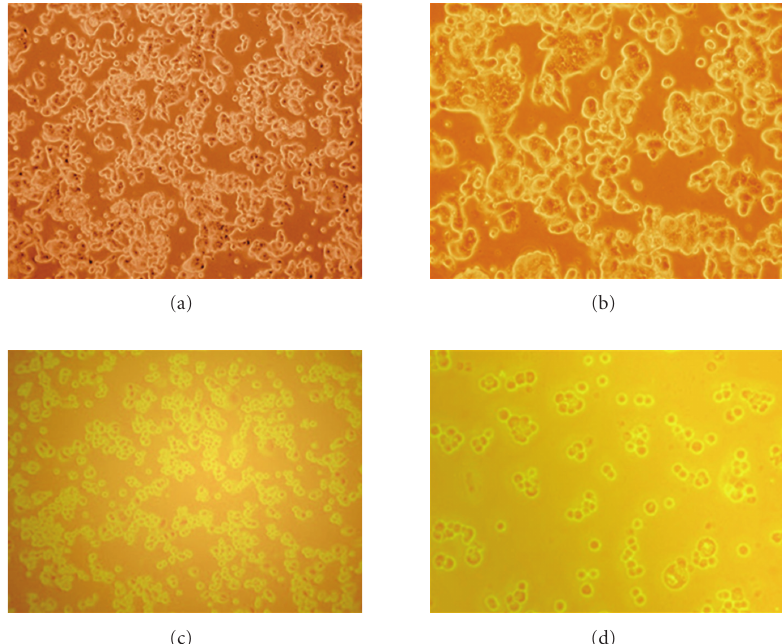
Figure 1: (a) Normal MCF-7 cells. (b) Anthocyanin treated MCF-7 cells showing spherical shaped cells leading to loss of cell anchorage with concentration of 1000 μ g/mL. (c) Anthocyanin treated MCF-7 cells showing spherical shaped cells leading to loss of cell anchorage with concentration of 500 μ g/mL. (d) Anthocyanin treated MCF-7 cells showing spherical shaped cells leading to loss of cell anchorage and cell number was also reduced with concentration of 250 μ g/mL.